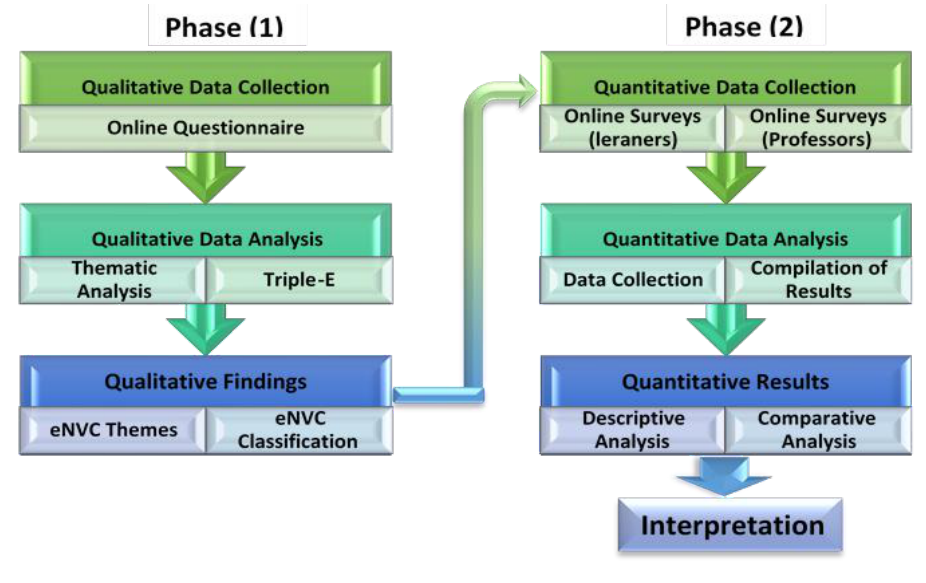
Figure 1. Sequential exploratory mixed-method